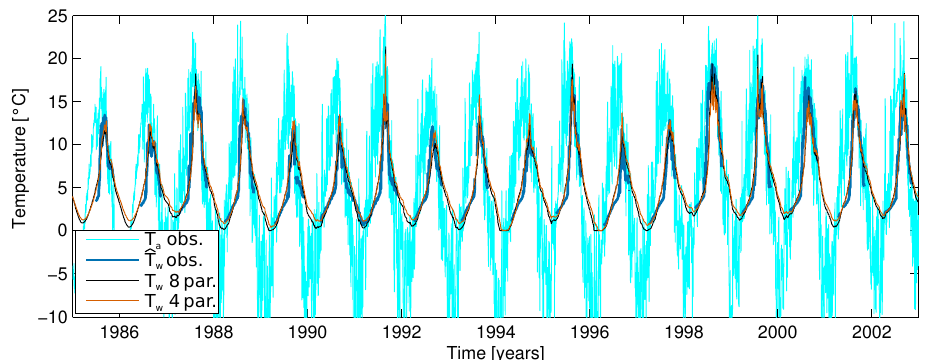
Fig. 5. Comparison between simulated and observed surface water temperature during the calibration period 1985–2002 (NDBC simulation). Fig.5. Comparison between simulatedand observed surface watertemperature during thecalibrationperiod 1985-2002 (NDBCsimulation). Simulated curves refer to the full eight-parameter and the simplified four-parameter models. Observed air temperature data are also presented Simulated curves refer to the full 8-parameter and the simplified 4-parameter models, respectively. Observed air temperature data are also with cyan line. presented with cyan line.